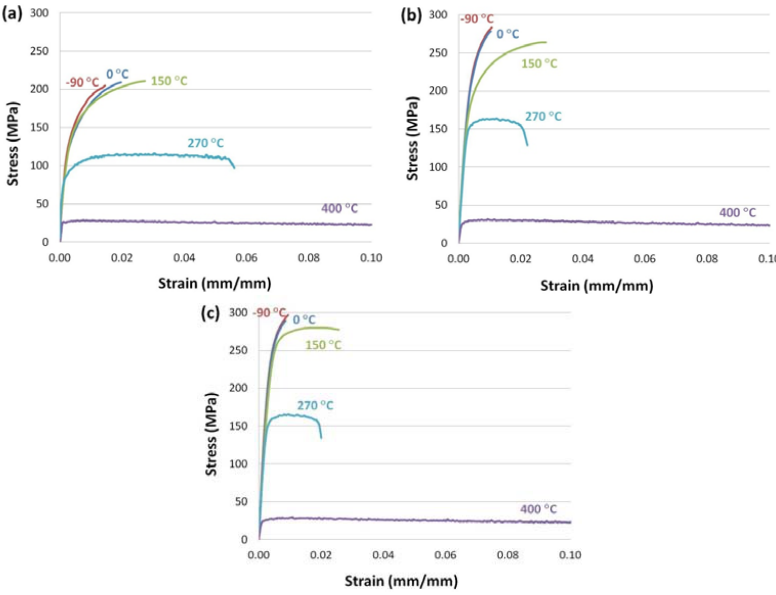
Figure 2. Examples of tensile stress ‐ strain curves at various temperatures ( − 90, 0, 150, 270, and 400 °C) from ( a ) as ‐ cast; ( b ) W; and ( c ) T7 specimens.